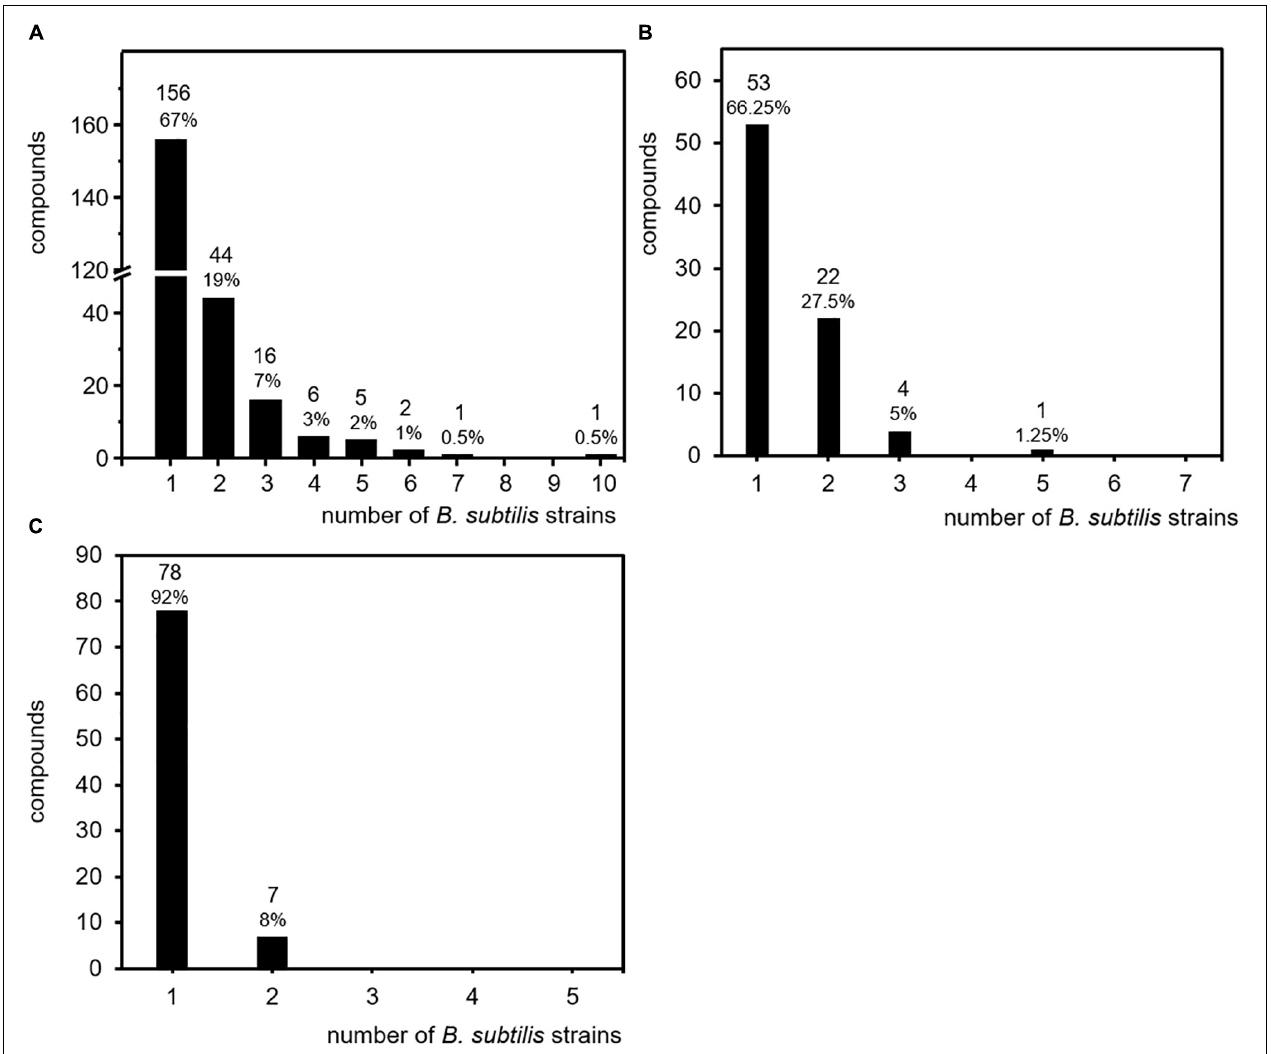
FIGURE 3 | Specificity of volatile secondary metabolites. Volatile secondary metabolites emitted by 26 B. subtilis isolates were summarized from 20 original scientific publication (see Table 1 ). Compounds were related to the number of isolates responsible for emission. (A) Production frequency of all 231 compounds (entire data set of the survey). (B) Production frequency of compound emitted upon cultivation on lysogeny broth (LB). (C) Production frequency of compounds emitted upon cultivation on nutrient broth